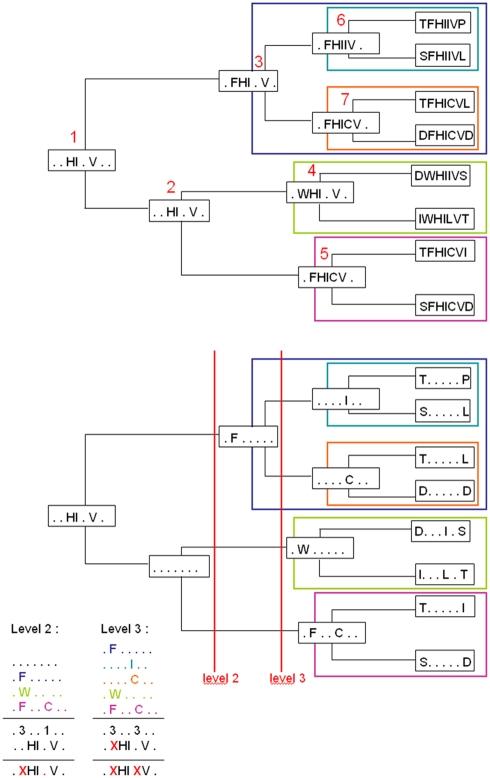
Schema of the tree trace computation.Top: tree with nodes labeled with consensus sequences: conserved residues
are traced from the leaves back to the root. Ranks of nodes are labeled
in red and . Subtrees of nodes of rank 2 and 3 are contoured with
colored boxes. Bottom: tree with nodes labeled with back-trace
sequences: back-traces are traced from the root back to the leaves. 3
subtrees corresponding to level 2 (blue, green and rose boxes) and 4 to
level 3 (turquoise, orange, green and rose boxes). On the bottom left,
schema of the computation of tree traces of level 2 and 3 based on 3 and
4 subtrees. Tree traces of level 2 (3) occupies the second (fifth)
position in the sequence and it is denoted by X.